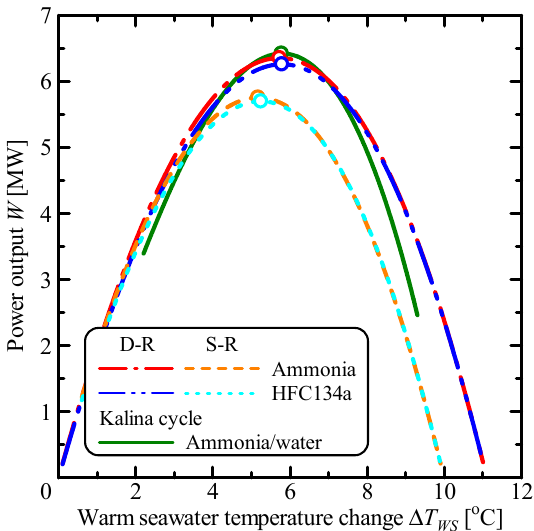
Figure 9. Relationship between the power output and the warm seawater temperature change.